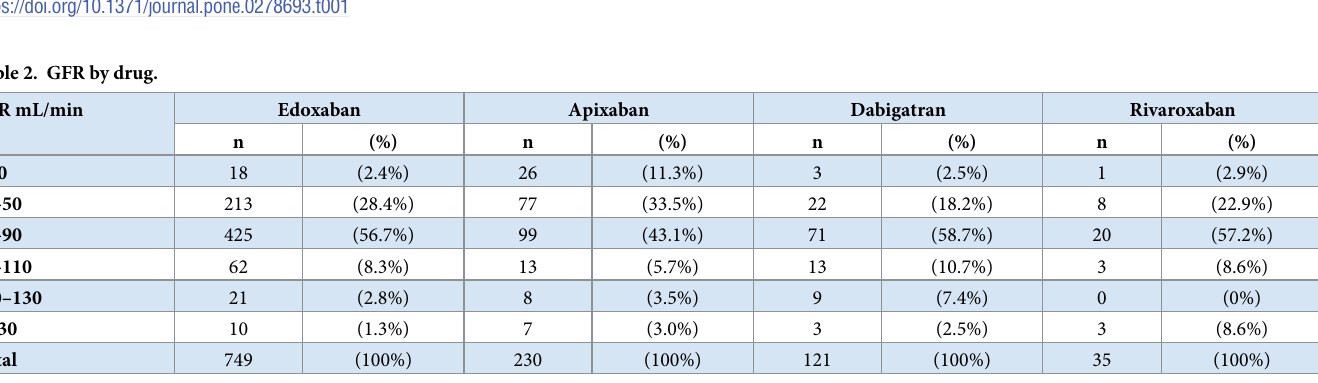
Table 2. GFR by drug.